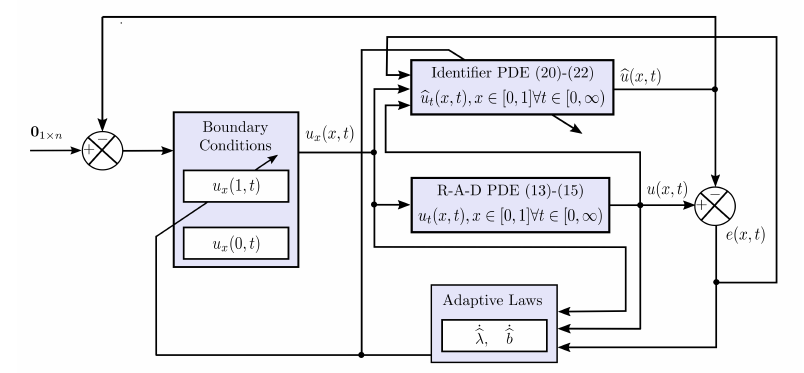
Figure 1. Adaptive boundary control scheme for the R–A–D PDE system